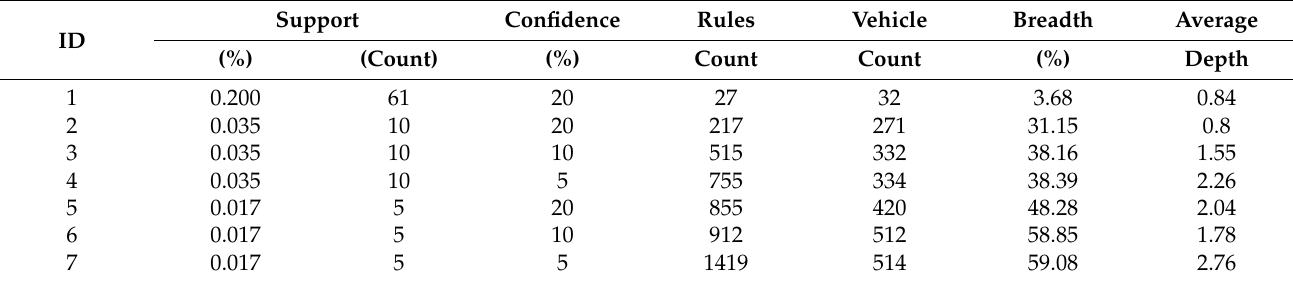
Table 1. Study 1: Association rules with various